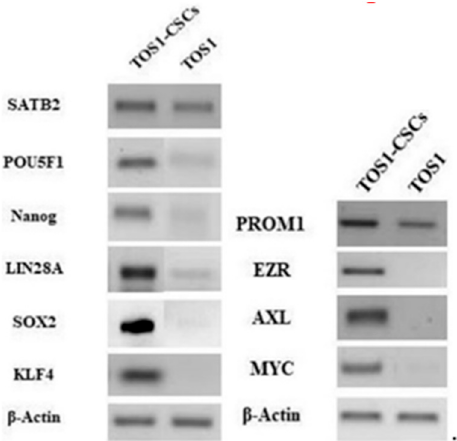
9 of 30 of human fibroblast cell line (negative control). LSCM in conventional colors: green for c-Kit and Nestin and blue for nuclei. Original magnifications: 10×. Bar size: 100 µm.